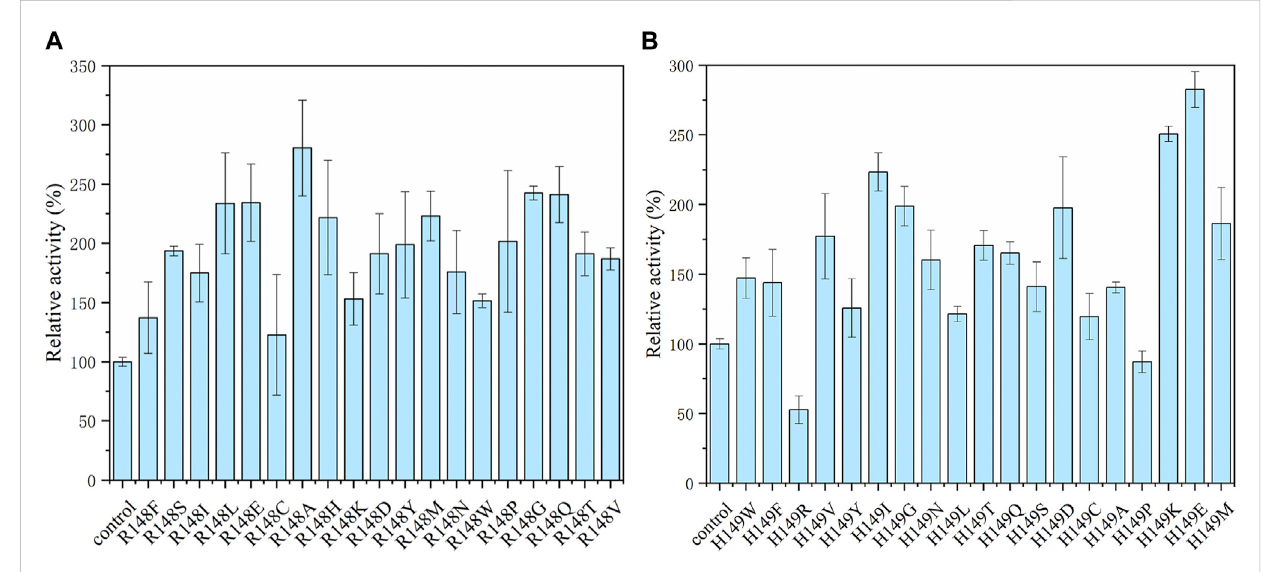
FIGURE 5 Site-directed saturation mutagenesis of EcNudc . (A) Relative activity with saturation mutations at the R148. (B) Relative activity with saturation mutations at the H149.